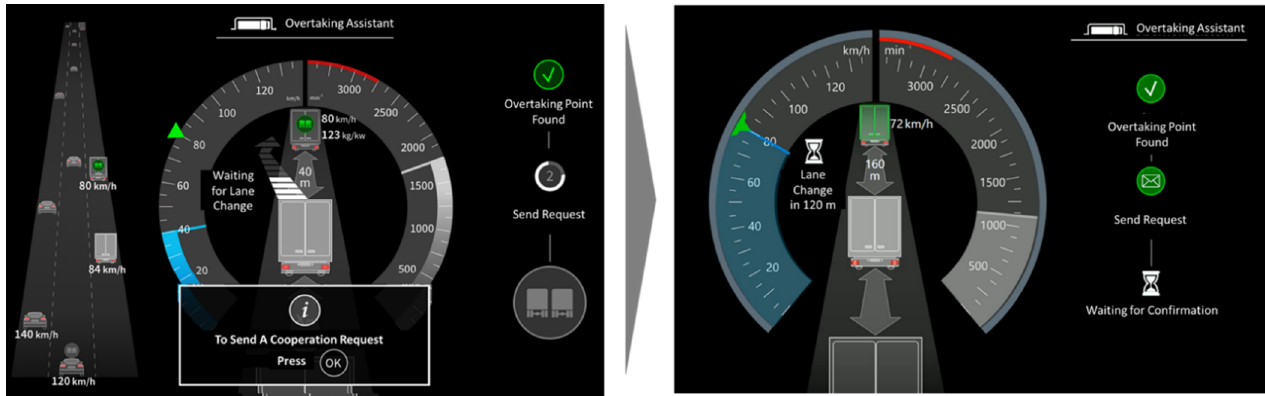
Figure 1. The HMI concept ( right ) in comparison to the HMI (according to [9]) ( left ) (figure shows all information simul- taneously).